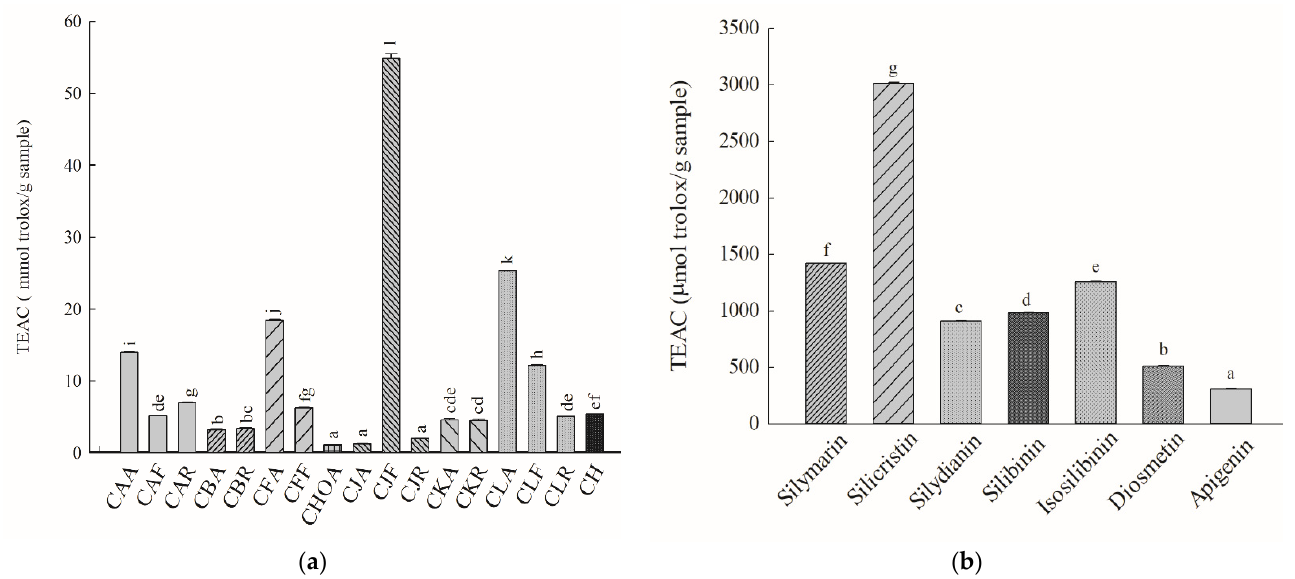
Figure 4. ABTS scavenging activities of the methanolic standardized extracts of Cirsium species and Cirsii Herb. ( a ) The methanolic standardized extracts of Cirsium species and CH; ( b ) all ingredients of the methanolic standardized extracts of Cirsium species and CH. Data are expressed as means ± SD (n = 3). ABTS, 2,2 ′ -azino-bis-3-ethylbenzthiazoline-6-sulfonic acid; CAA, the aerial part of C. arisanense ; CAF, the flower part of C. arisanense ; CAR, the radix part of C. arisanense ; CBA, the aerial part of C. brevicaule ; CBR, the radix part of C. brevicaule ; CFA, the aerial part of C. ferum ; CFF, the flower part of C. ferum ; CHOA, the aerial part of C. hosokawae ; CJA, the aerial part of C. japonicum DC. var. australe ; CJF, the flower part of C. japonicum DC. var. australe ; CJR, the radix part of C. japonicum DC. var. australe ; CKA, the aerial part of C. kawakamii ; CKR, the radix part of C. kawakamii ; CLA, the aerial part of C. lineare ; CLF, the flower part of C. lineare ; CLR, the radix part of C. lineare ; CH, Cirsii Herb. Bars with different letters indicate statistical significances, p < 0.05.